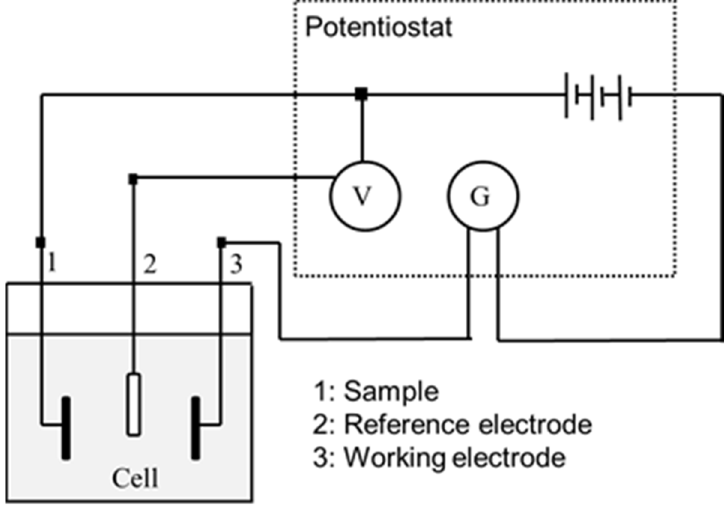
Figure 1. Experimental set up used for corrosion resistance.